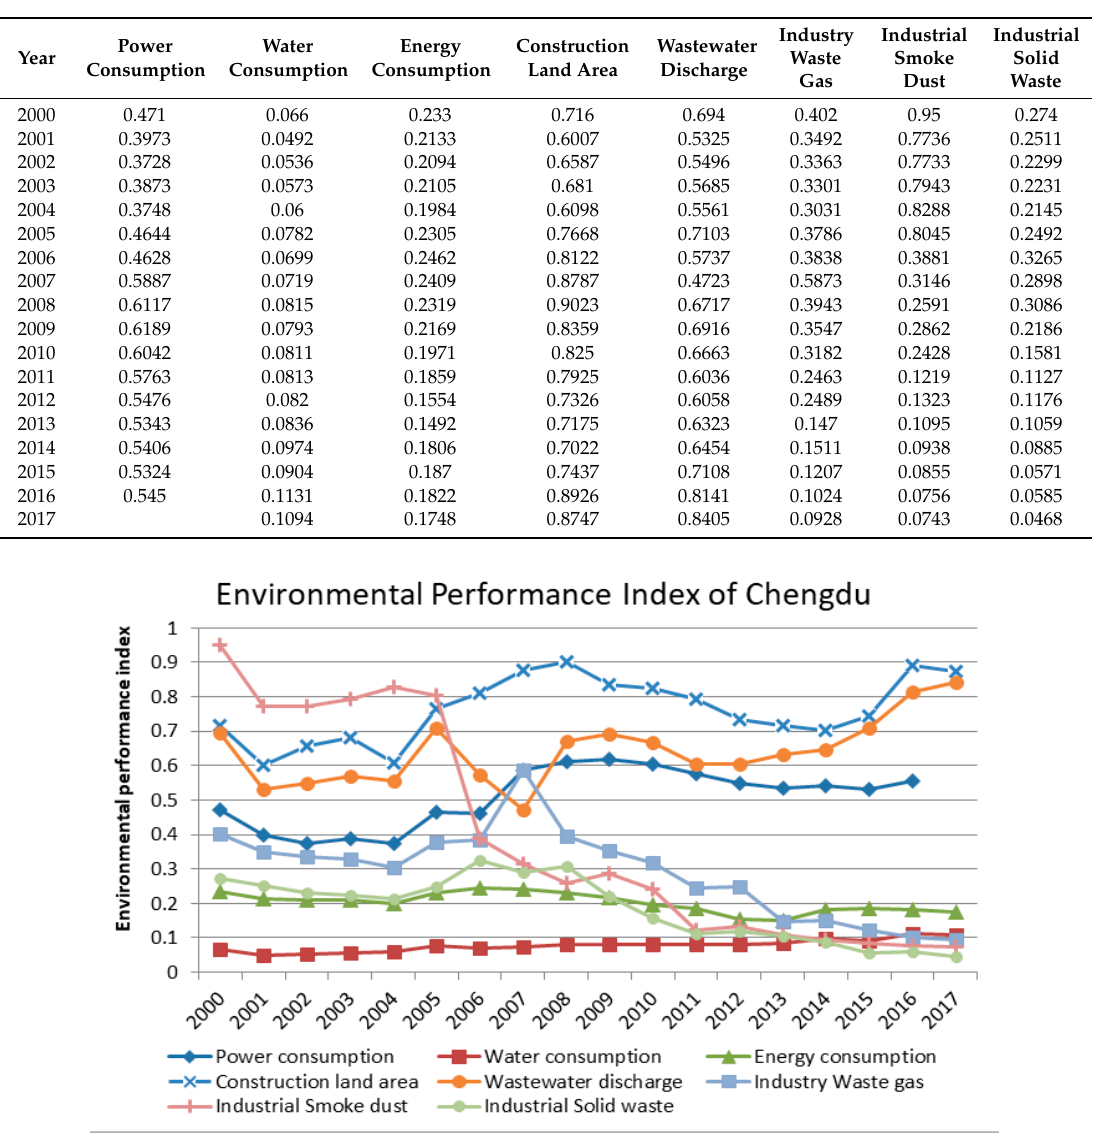
Figure 4. EPI of eight environmental factors in Chengdu from 2000 to 2017.